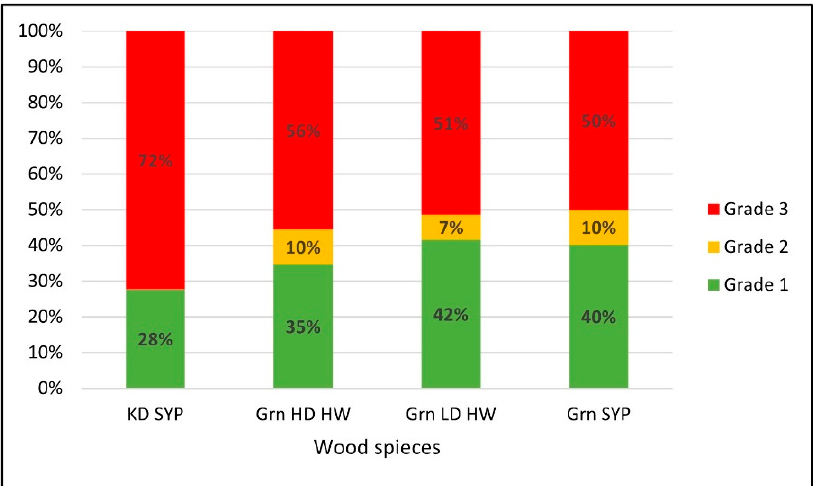
Figure 6. Changes in the proportions of the different grade scenarios in response to the pallet wood species. Note: KD SYP: kiln-dried southern yellow pine, Grn HD HW: green high-density hardwood, Grn LD HW: green low-density hardwood, Grn SYP: green southern yellow pine.